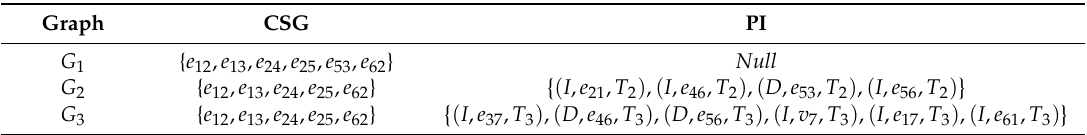
Figure 3. Generation of an Intersection Snapshot (IS): ( a ) G 1 at time T 1 ; ( b ) G 2 at time T 2 ; ( c ) G 3 at time T 3 ; ( d ) IS. Table 1. Graph pattern table. PI: Provenance Information.